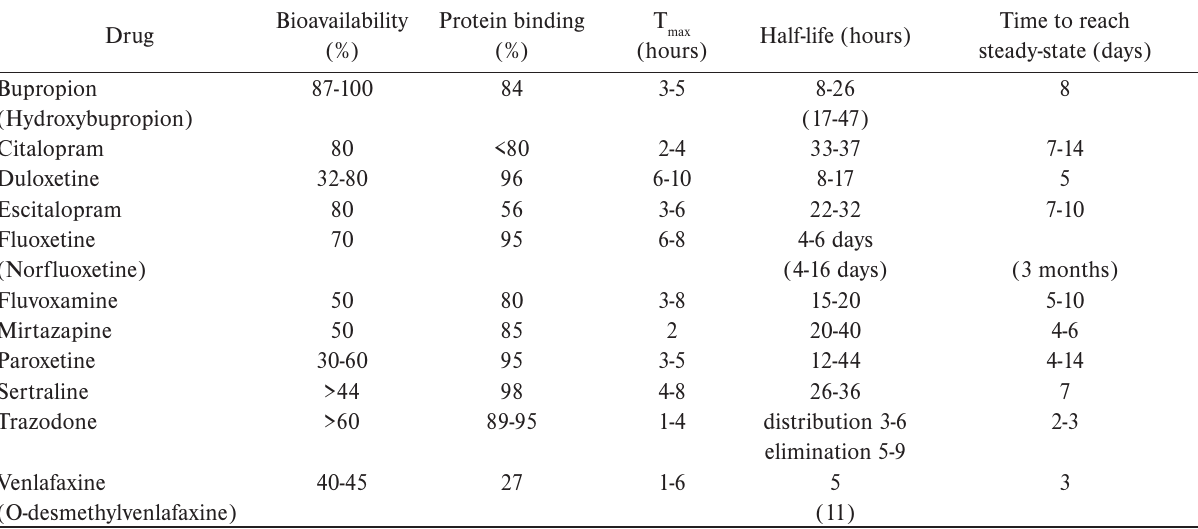
Table 1. Basic characteristic of antidepressant drugs 9,12,48,54